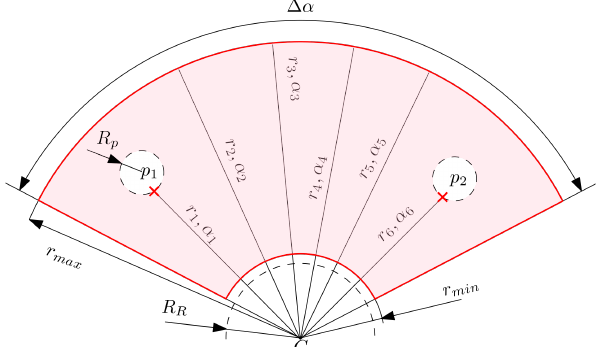
Figure 3. Working principle of the 2D LiDar range sensor. The figure shows a general scanning area, positioned ahead of the WMR, defined by ( r min , r max , ∆ α , n rays ) , in which two pedestrians are